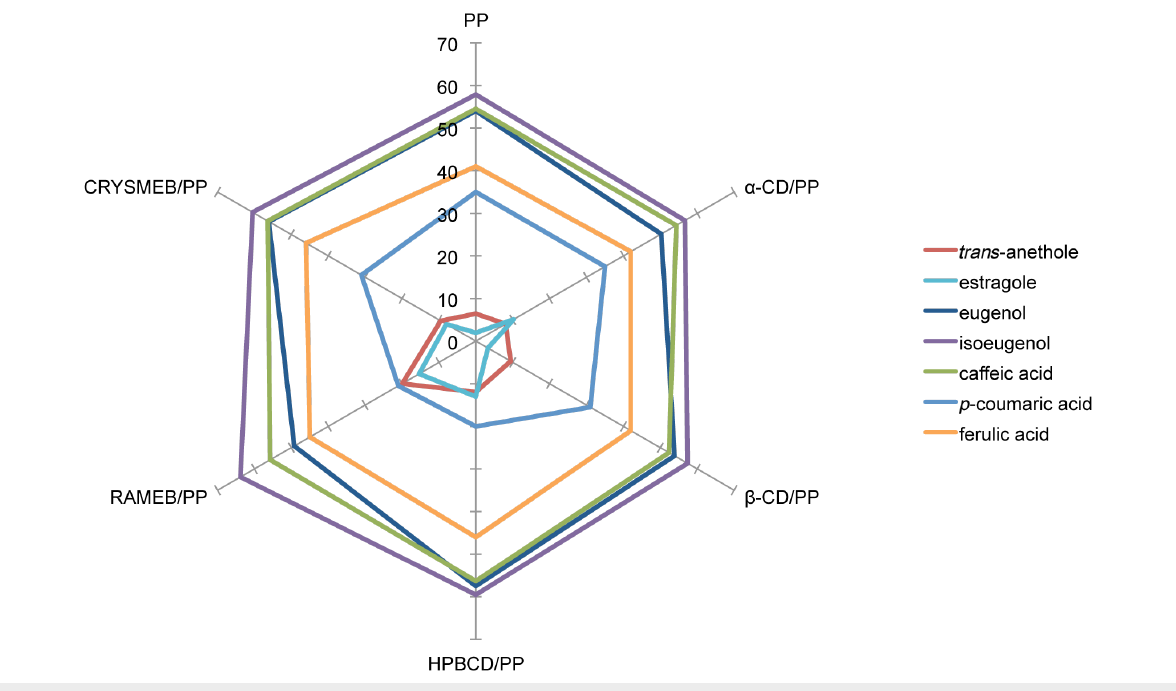
Figure 5: DPPH radical scavenging activity (%) of studied PPs alone or in presence of CD.